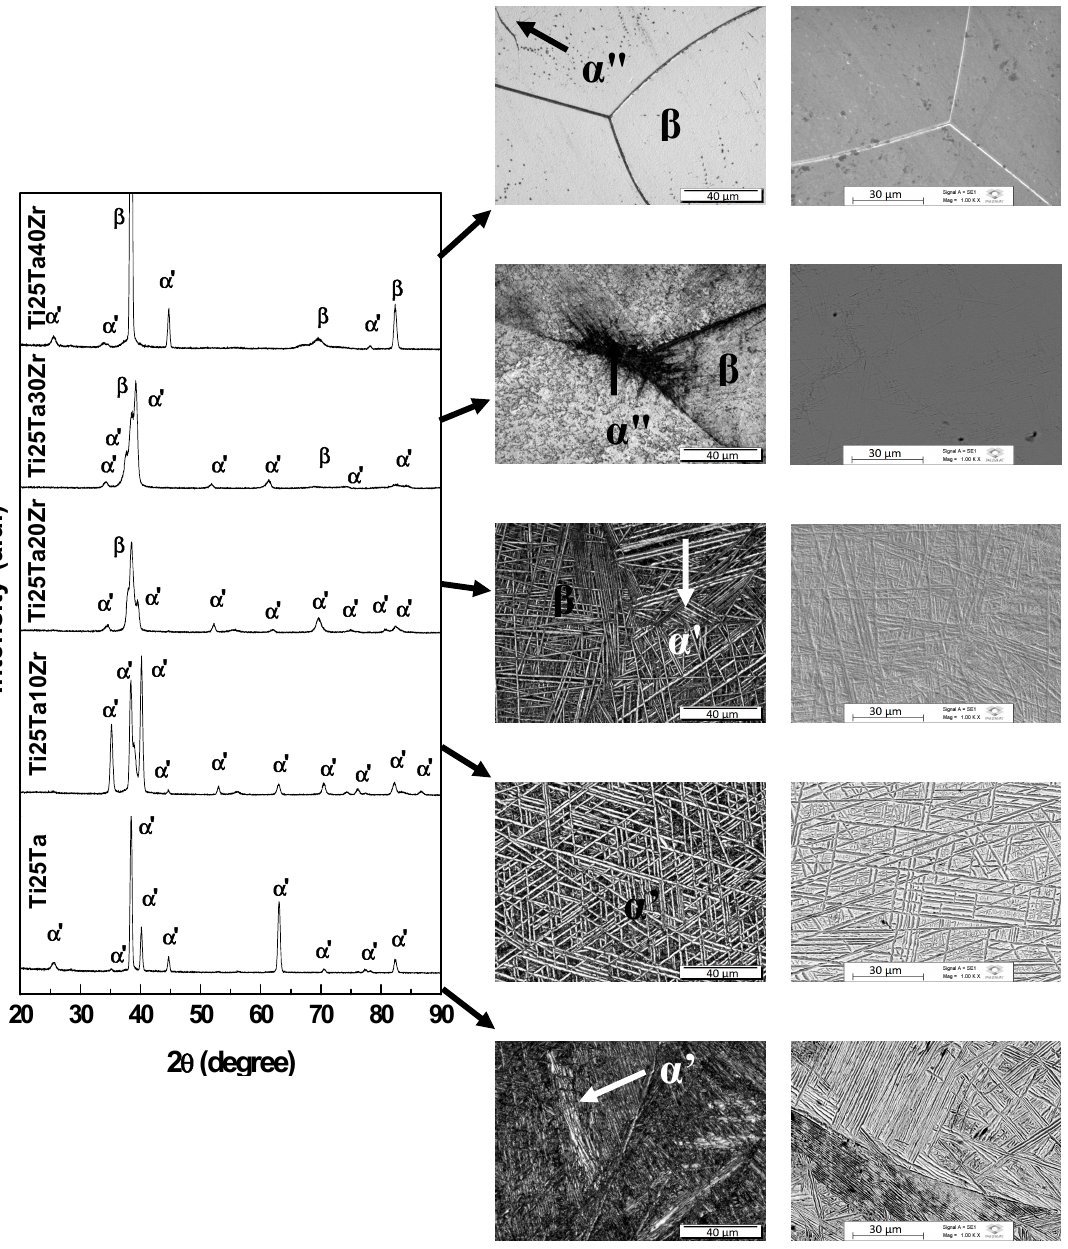
Figure 2. X-ray diffraction patterns and optical and SEM micrographs for Ti-25Ta-xZr system alloys after annealing heat treatment with slow cooling.